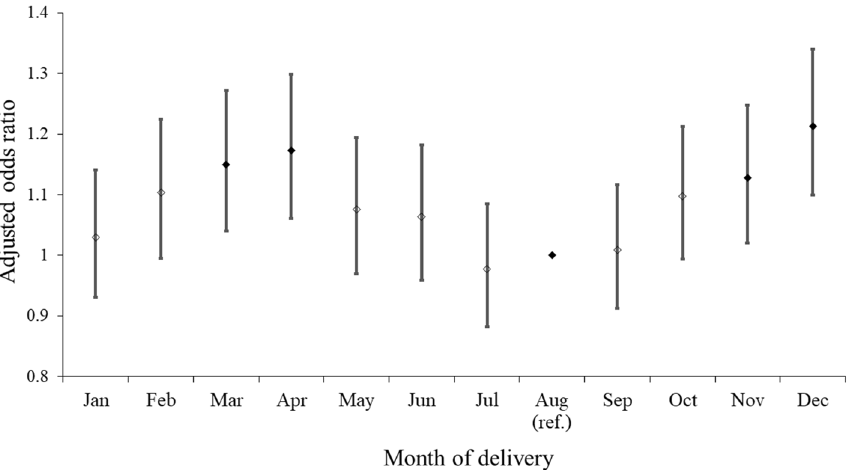
Figure 3. Association between the month of delivery and preeclampsia. *Adjusted for age at the time of delivery, income status, residential area, smoking status, drinking status, physical activity, body mass index, history of hypertension before pregnancy, diabetes mellitus, and upper respiratory infection during pregnancy.